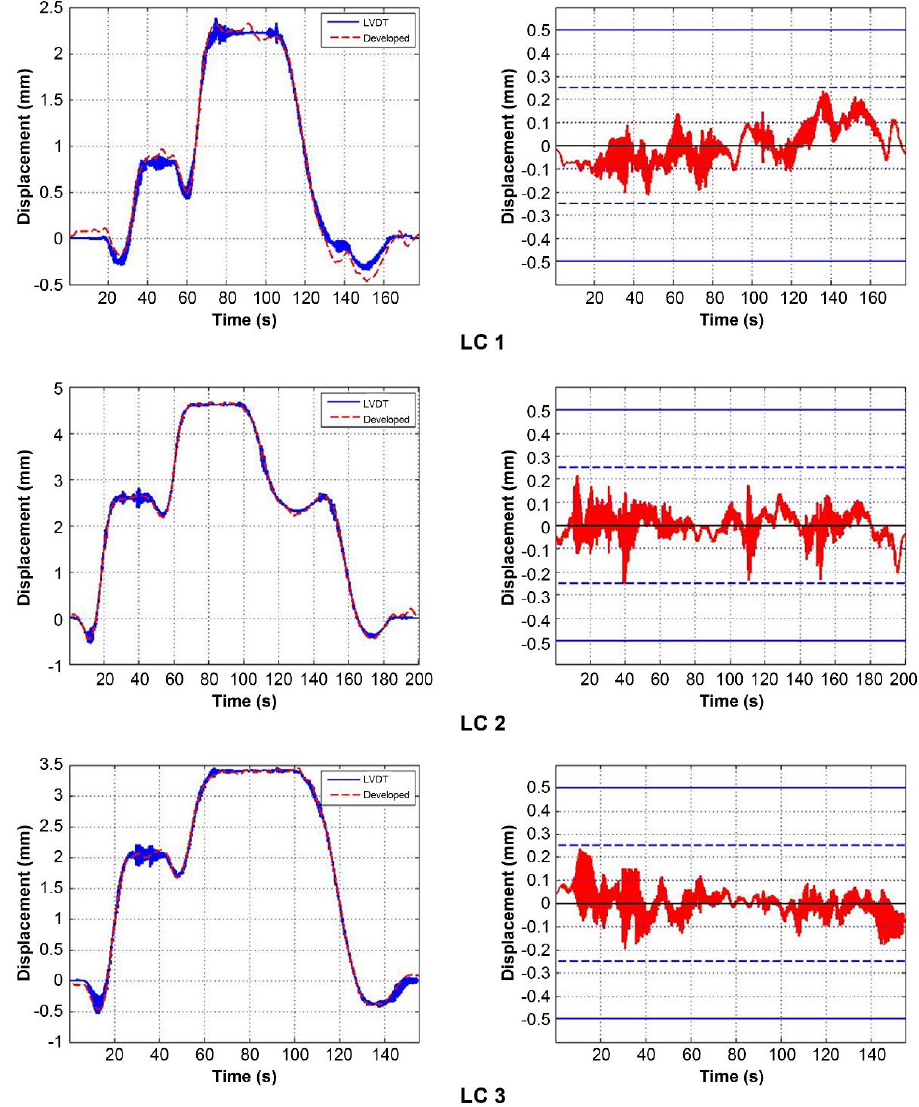
Figure 11. Signal comparison and errors of the static loading test.